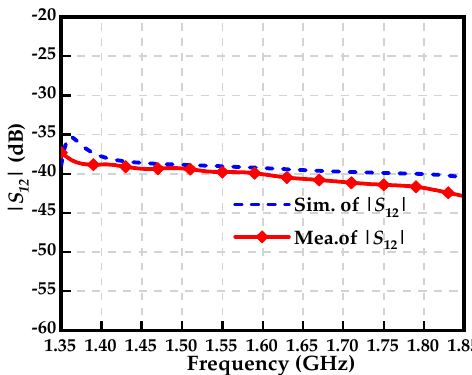
Figure 9. Test setup for characterizing the transmission coefficient of the proposed sensor. ( a ) Schematic diagram and (b ) photo of the test setup in the half-wave anechoic chamber.